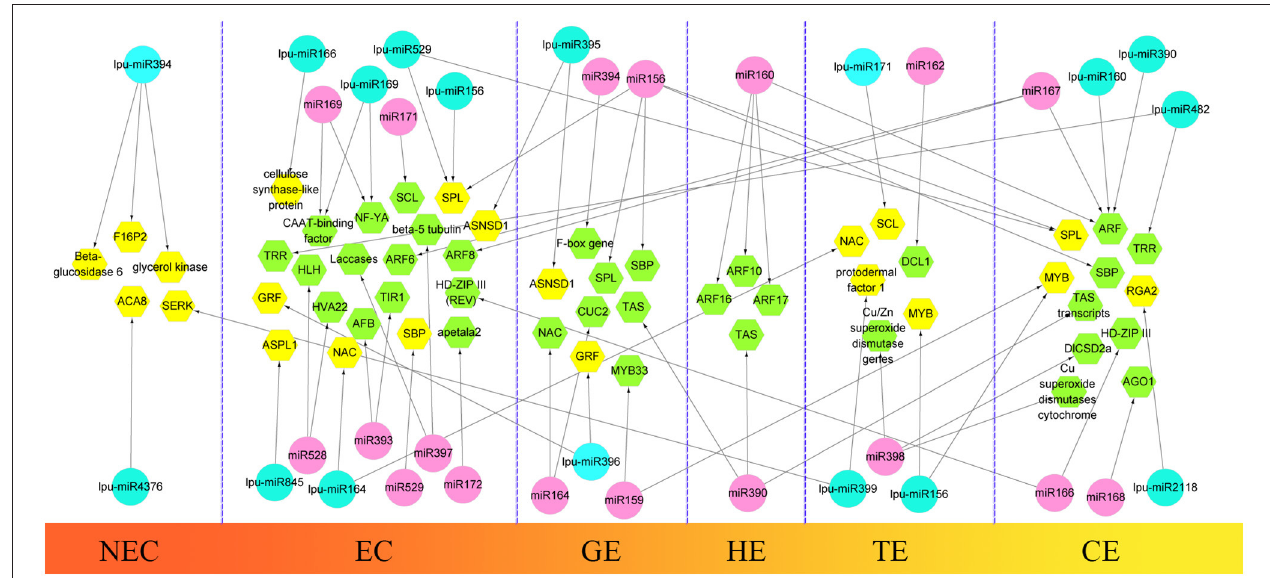
FIGURE 9 | Comparison of hypothetical schematic model of miRNA-mediated interaction network during SE in Lilium pumilum DC. Fisch. and other plants. The miRNAs and potential targets in Lilium pumilum DC. Fisch. are shaded in blue and yellow, respectively. The black arrows denote the relationship between miRNAs and potential targets identified and predicted in this study. The miRNAs and potential targets in other plants are shaded in pink and green, respectively. The black arrows denote the relationship between miRNAs and potential targets according to previous reports listed in Table